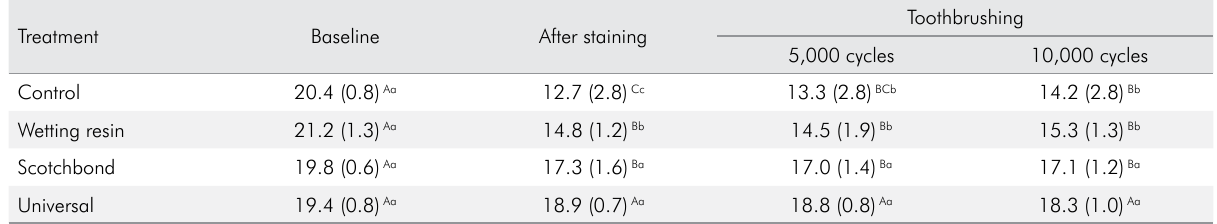
Table 4. Mean and standard deviation (SD) of whitening index values according to treatment and assessment time intervalsa.